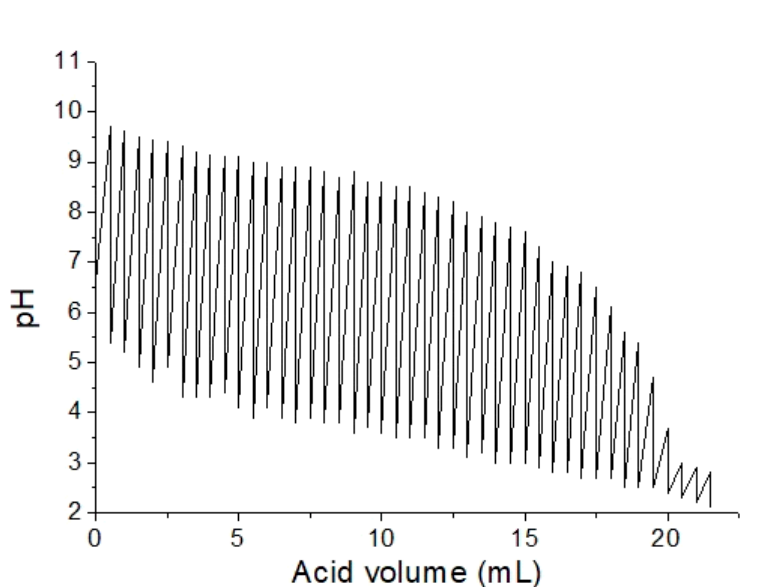
Figure A1. Neutralization curve of Mg(OH) 2 (MH) with a sulfuric acid solution (0.4 M), adding a 0.5 mL drop of acid per minute.